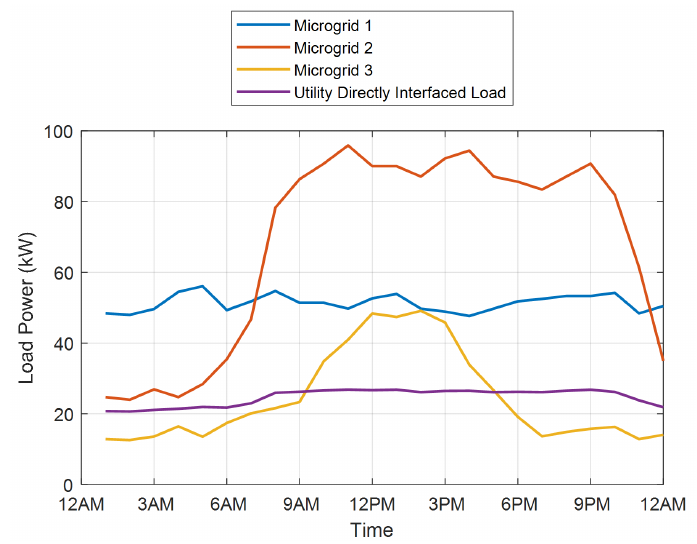
Figure 3. System Loads.